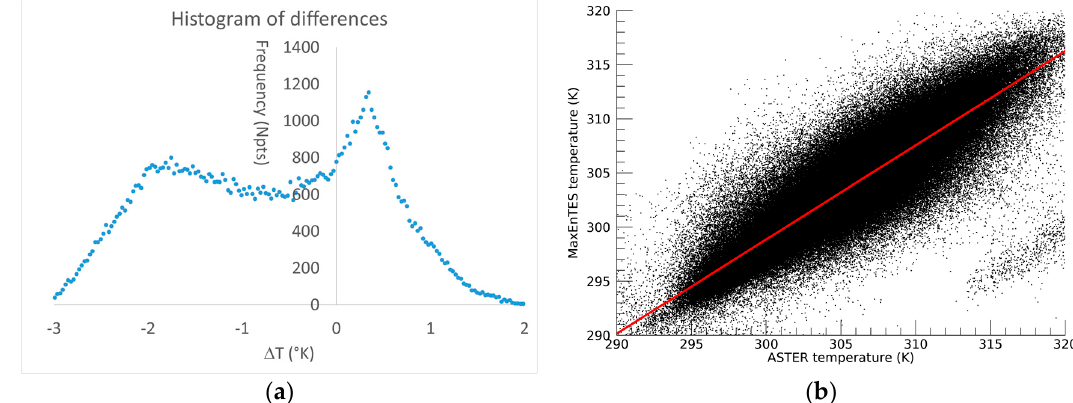
Figure 3. MaxEnTES applied to simulated and real data: ( a ) Simulated data: histogram of the differences between the temperatures retrieved using MaxEnTES and those used for the